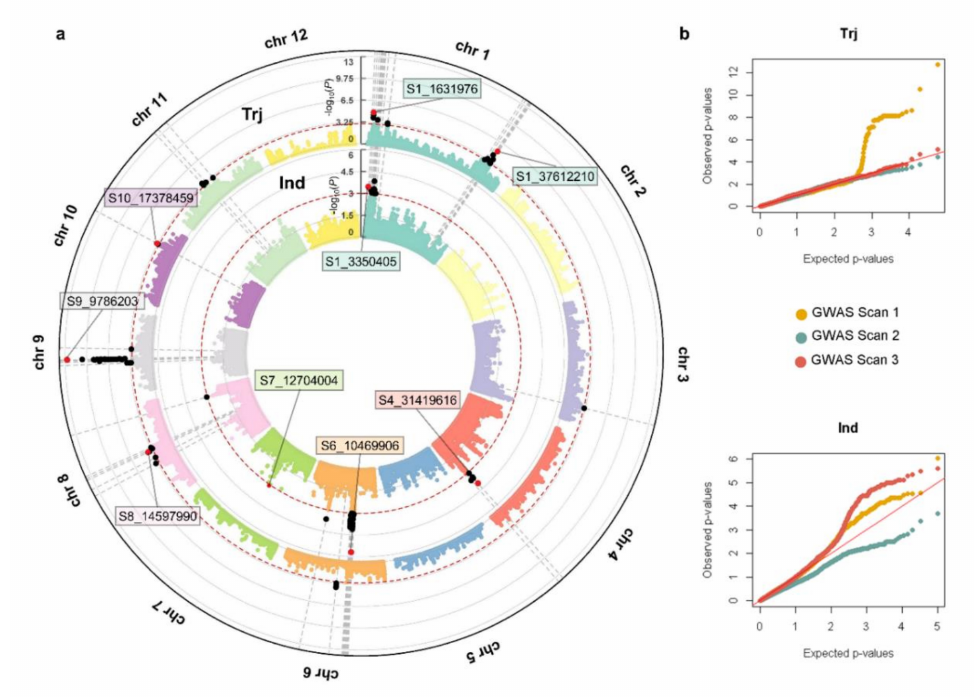
Figure 3. Results of GWAS scans 1, 2, and 3 for tropical japonica (Trj) and indica (Ind) subpopulations. ( a ) Circular Manhattan plots with scans 1, 2 and 3 overlaid for Trj (outer circle) and Ind (inner circle). Significant single nucleotide polimorphisms (SNPs) are highlighted in black, and the SNP with the highest − log 10 ( p ) within each quantitative traitl loci that was significant in the multi locus model is labelled and colored in red. ( b ) Quantile-quantile plots of GWAS scans 1, 2 and 3 for tropical japonica (Trj) and indica (Ind) subpopulations.